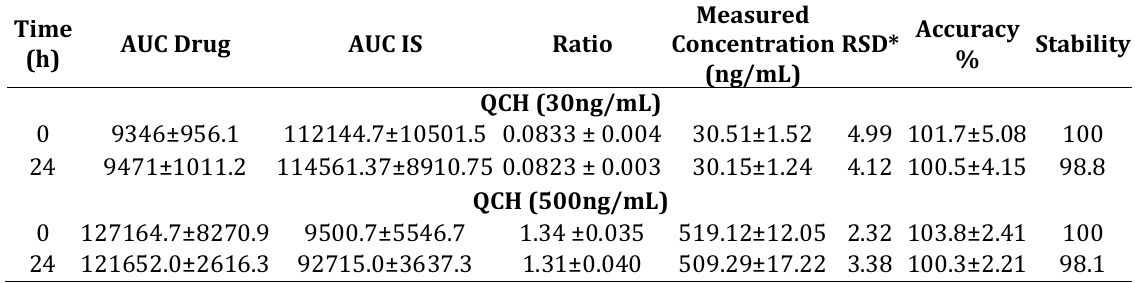
Table III. Montelukast QC samples stability at 4°C (auto sampler stability); QCL (30ng/mL) and QCH (500ng/mL).